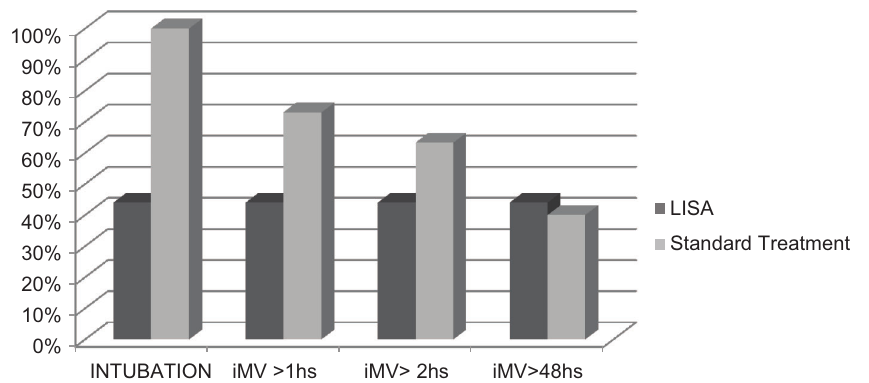
Figure 2 - Patients who needed intubation and invasive mechanical ventilation after less invasive surfactant administration or standard